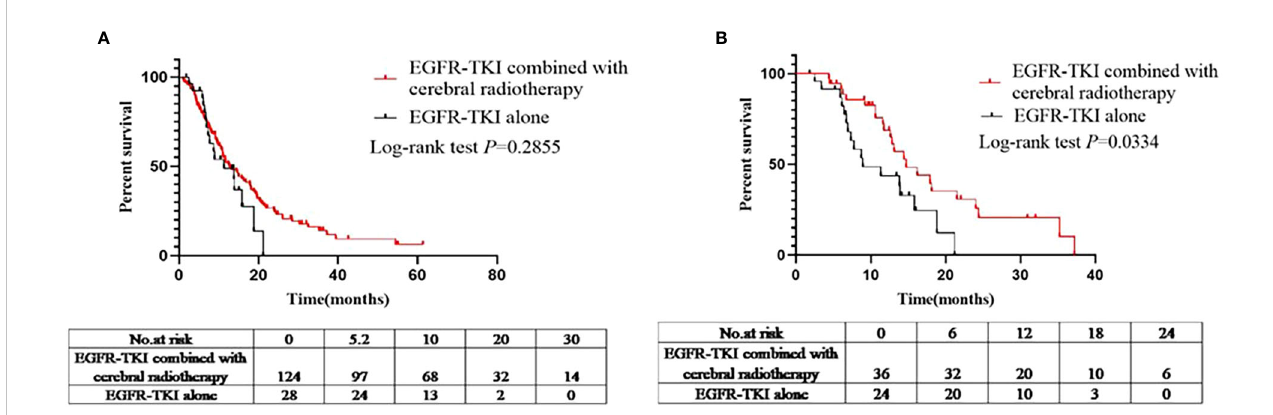
FIGURE 2 (A) Comparison of iPFS between the EGFR-TKIs combined with cerebral radiotherapy group and EGFR-TKI alone group before PSM. (B) Comparison of iPFS between the EGFR-TKIs combined with cerebral radiotherapy group and EGFR-TKI alone group after